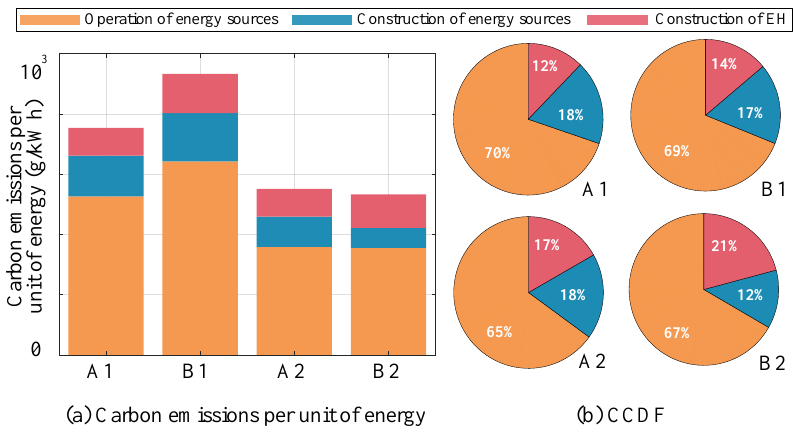
Figure 8. The CCDF index of two consumers with different energy usage habits at two periods.